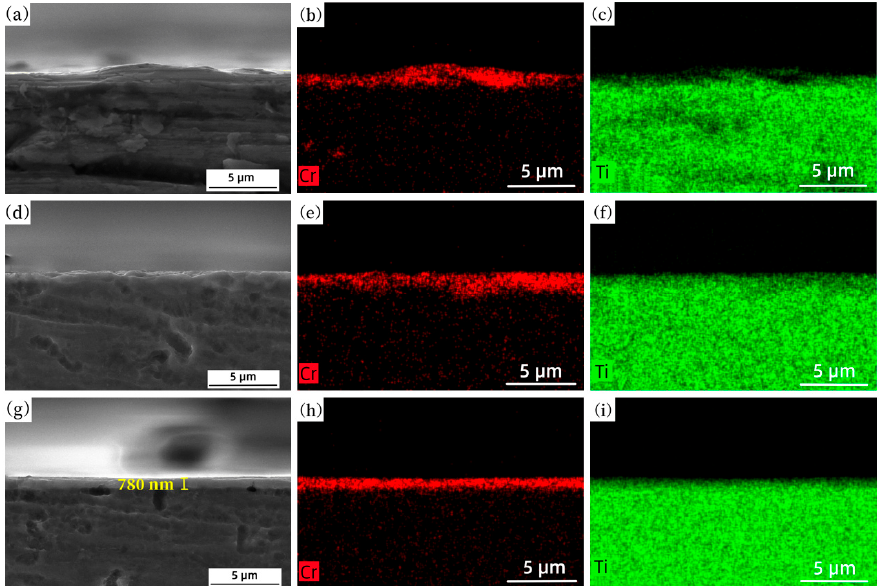
Figure 6. Cross-section EDS mapping of Ti-Cr alloy coating formed by ( a – c ) 1 pulse, ( d – f ) 5 pulses, ( g – i ) 20 pulses of IPIB treatment.